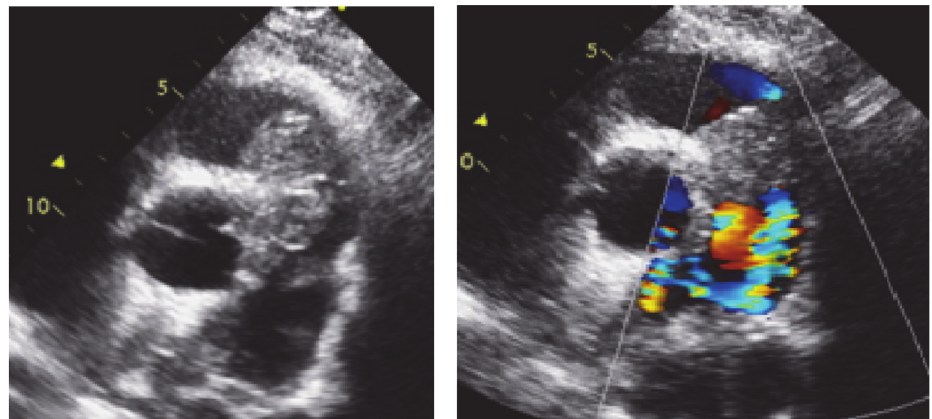
Figure 1: 2D transthoracic echo images in short axis parasternal view showing a large echodense RVOT mass, with signal aliasing on color